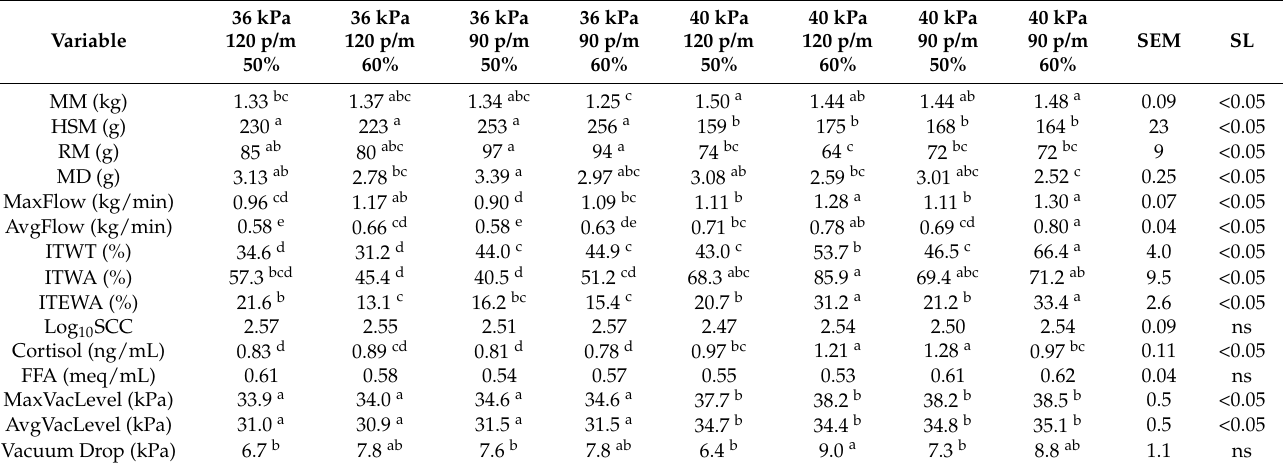
Table 1. Effect of the treatment (combinations of system vacuum, pulsation rate and pulsator ratio) on variables related to milking fractioning, milking efficiency, teat end status, milk composition, animal welfare and vacuum measured in the short milk tube in Murciano-Granadina goats milked in mid-line pipes (least square means ± standard error of the